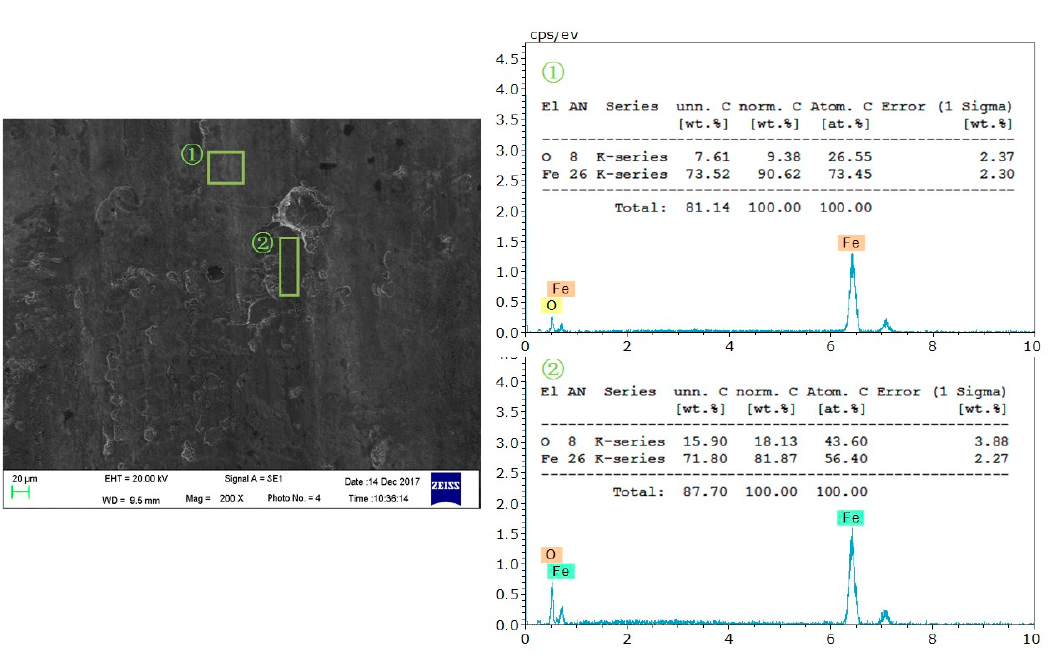
Figure 6. Energy dispersive spectrometry (EDS) spectra of strip surface lubricated with traditional lubricating